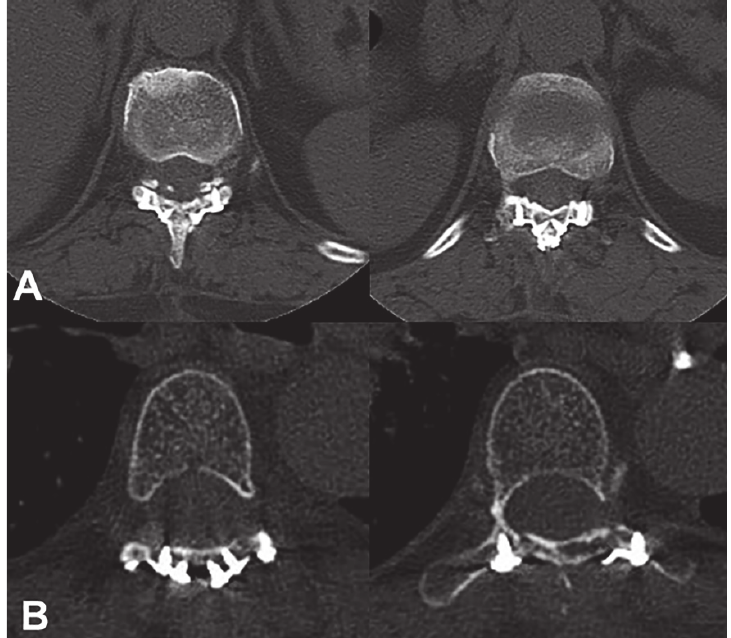
Figure 4. Bone fusion of the replanted lamina. ( A ) In a 55-year-old female patient, postoperative CT scan showed favorable bony fusion of the replanted lamina; ( B ) another 56-year-old female patient also had favorable bone